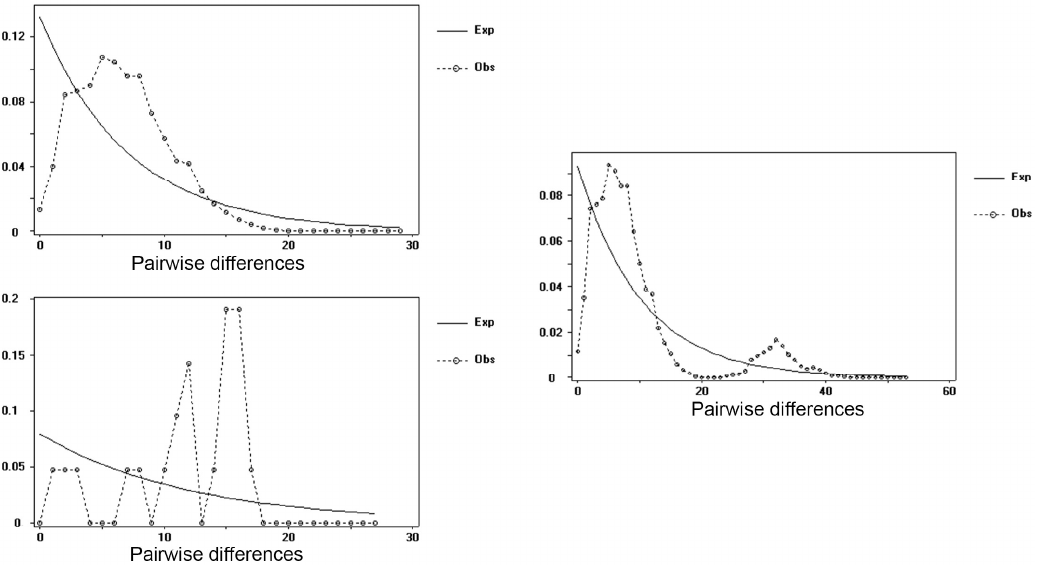
Figure 5. A sudden expansion model of the swimming crab P. sanguinolentus predicts the observed pair-wise differences and mismatch distributions.